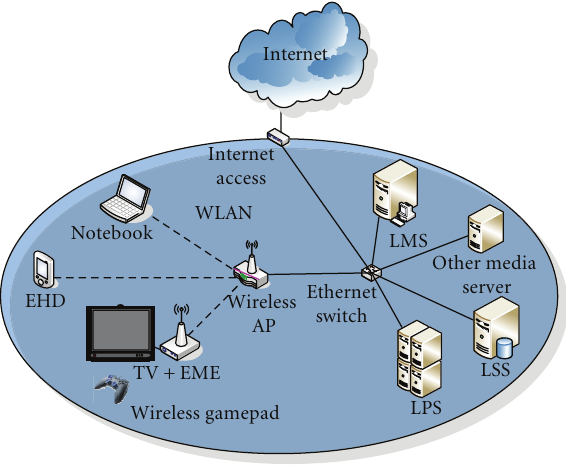
Figure 1: Games@Large